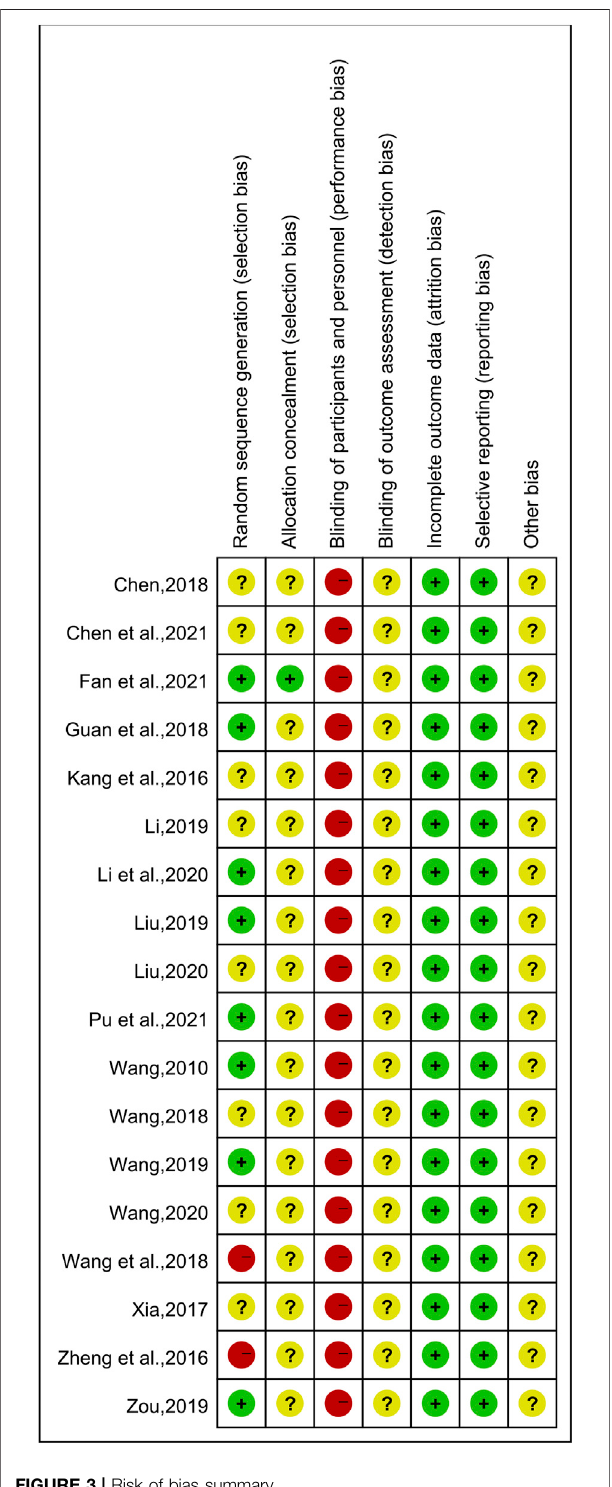
indices, liver functions, insulin, glycemic indices, and so on. For dichotomous data, a risk ratio (RR) with a 95% con fi dence interval (CI) was used to measure the results. Continuous variables, such as